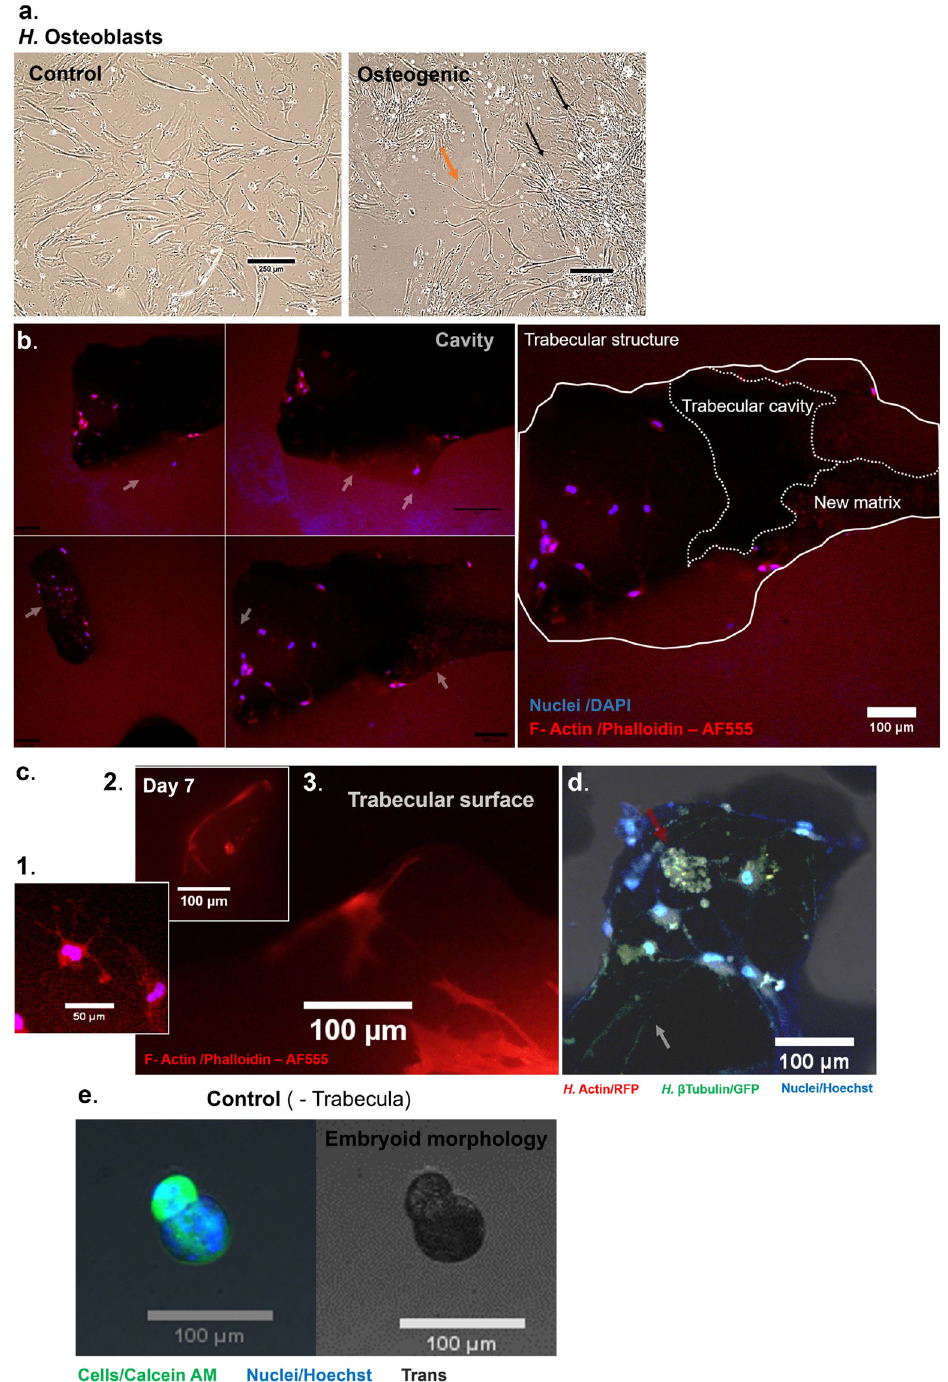
Fig. 3 Maturation of the human osteoblastic constructs and simulation of the osteoid producing events encountered in vivo. Human osteoblastic cells cultured in non-osteogenic (control) medium for 14 days ( a ) display an unchanged osteoblastic phenotype, whereas cells cultured in osteogenic medium for this period display a highly dendritic phenotype within an interconnected network, indicative of an osteocytic phenotype ( b ). Constructs seeded with cells and cultured on non-adherent surfaces for 7 days are able to recapitulate in vivo events such as osteoid production. New matrix is produced, which can be morphologically distinguished from the compact bone structure ( b , left, white arrows). Cavities within trabeculae are used as a sites where new matrix formation takes place ( b , right), and dendritic cells are seen embedded within this matrix ( c , 1). The surface of constructs is also a site of osteoblastic-osteocytic activity, with large projections extending across the trabeculae ( c , 2, 3). In addition, communication and aggregates (red arrow) can be observed at the surface, which are rich in tubulin and actin ( d ). e In contrast, constructs that were cultured in the absence of trabecula, including 7 days inside a perfused rotating vessel, develop a lobular embryoid-type morphology. Scale bars as